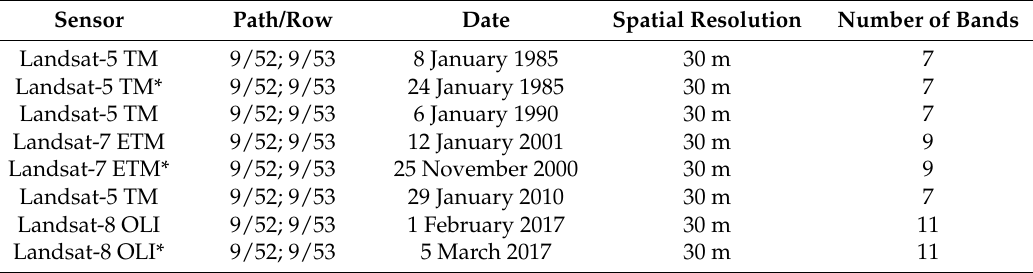
Table 1. Data used for land use and land